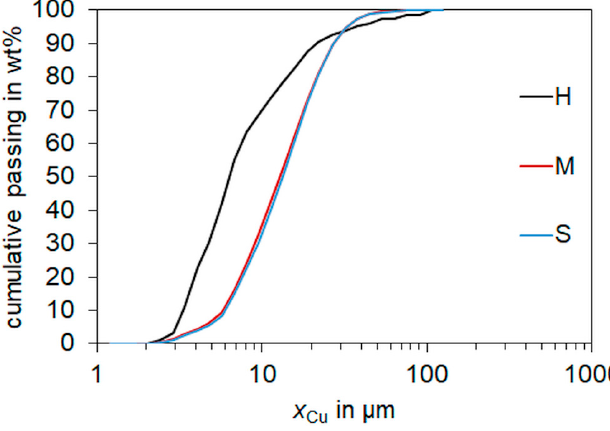
Figure 12. Cu-metal grain size distribution of the three different sampling areas.